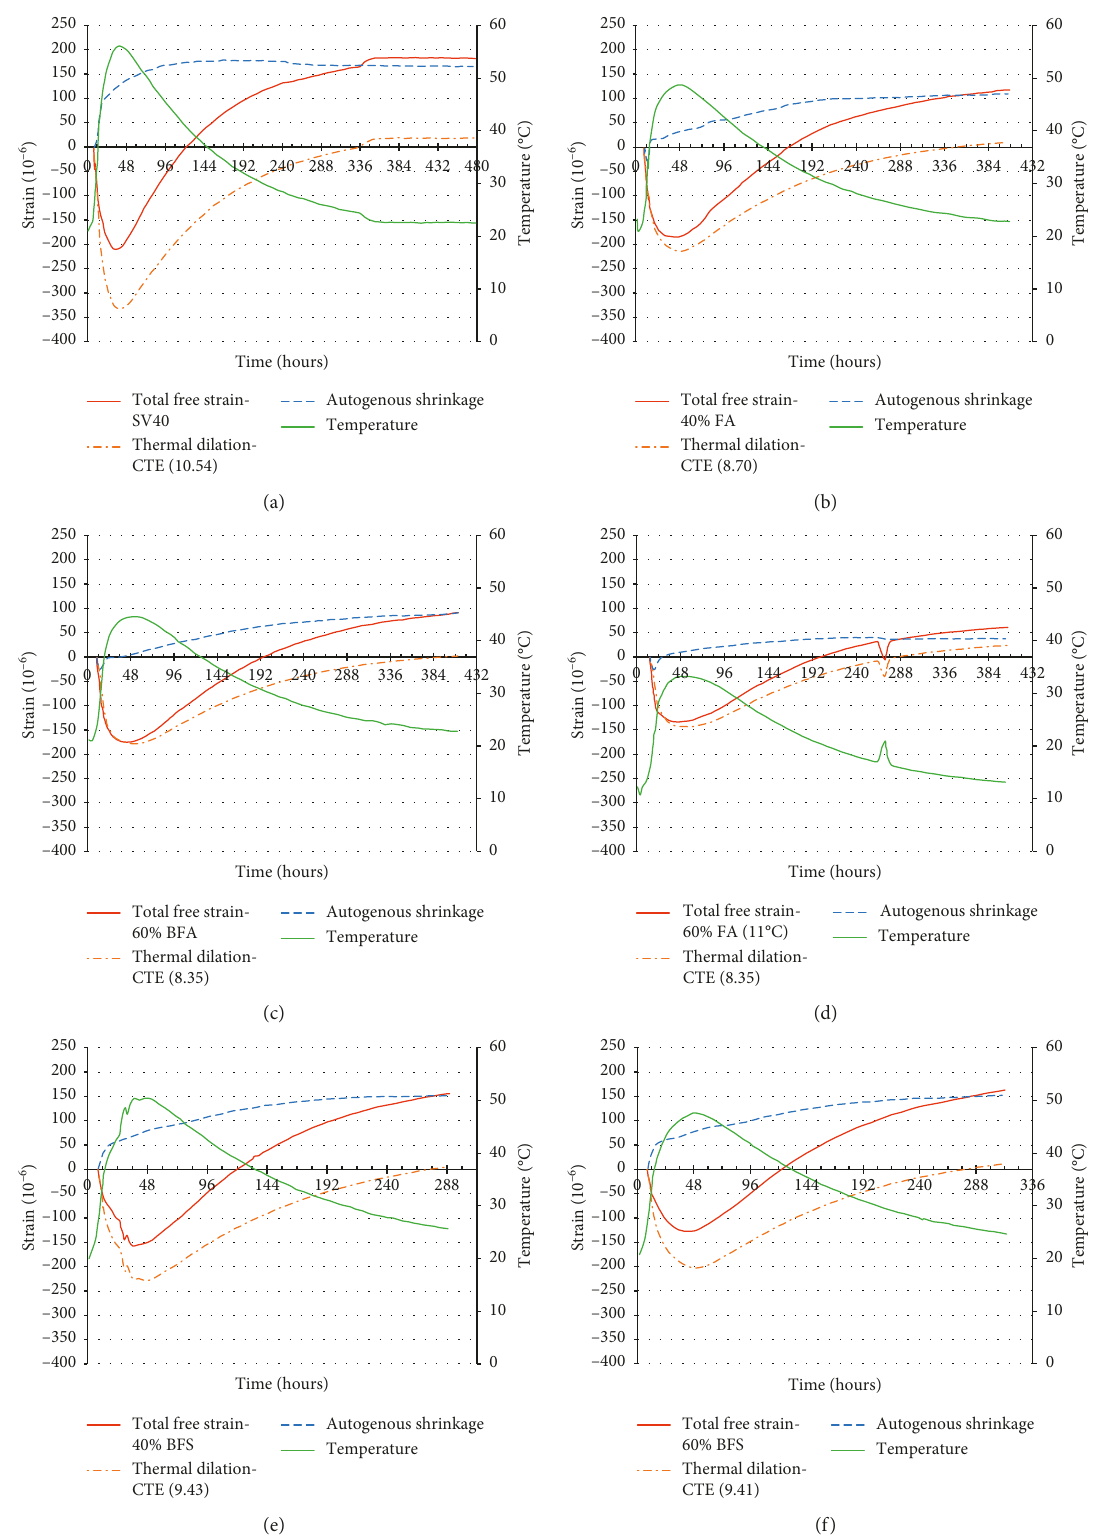
Figure 2: Free deformation and separated thermal dilation and autogenous deformation: (a) SV40; (b) 40% FA; (c) 60% FA; (d) 60% FA (11 ° C); (e) 40% BFS; (f) 60%